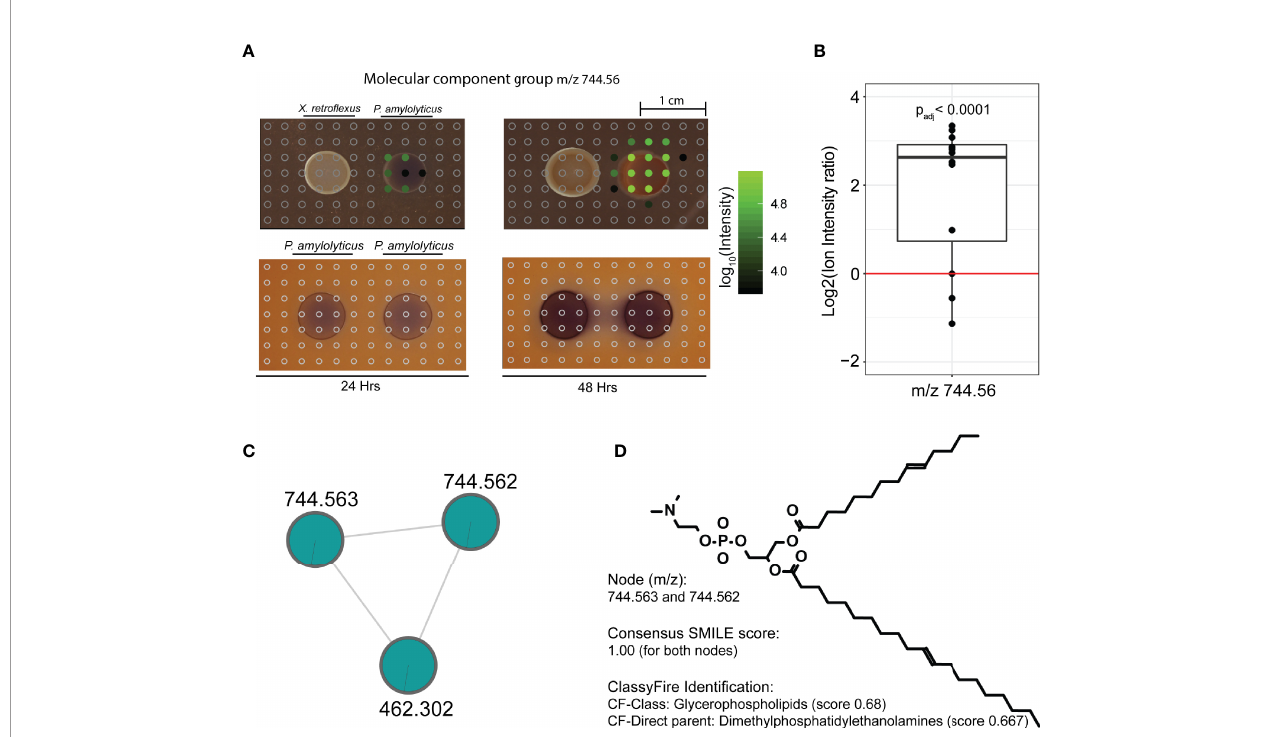
FIGURE 4 | Spatial distribution of a metabolite feature, unique to the inter-species interaction, across the bacterial colonies and their interaction zone. (A) Spatial distribution of molecular feature with m/z 744.56, unique to the interspecies interaction. Circles indicate positioning of excised agar plugs across the interaction zone. Empty grey circles refer to spots where the metabolite was not detected. Filled circles refer to plugs where the metabolite was detected, and color from black to green refers to Log10(MS1 ion intensity). Three data fi les were lost during analysis, which corresponds to the blank area without circles in the interaction zone. At 24 hrs the metabolite was only detected in the periphery of the P. amylolyticus colony facing the X. retro fl exus colony, whereas it was highly abundant across the entire P. amylolyticus colony at 48 hrs. (B) Ion intensity plot of the plugs covering the 48 hrs colony of the interacting P. amylolyticus , as compared to the non-interacting 48 hrs colony. For the interacting colony, MS1 ion intensities were divided by 3 to account for the higher observed cell count. Even when accounting for increased number of cells in the interacting colony and an inferred arti fi cial detection limit, metabolite m/z 744.56 was signi fi cantly more abundant in the interacting colony. (C) Molecular family containing mass spectral feature with m/z 744.56, for statistical analysis unique mass spectral features likely split during preprocessing with m/z 744.563 and m/z 744.562 were merged. The two nodes grouped together with an additional molecular feature, represented in Figure S8 . (D) In silico putative structure annotation identi fi ed the molecule as a